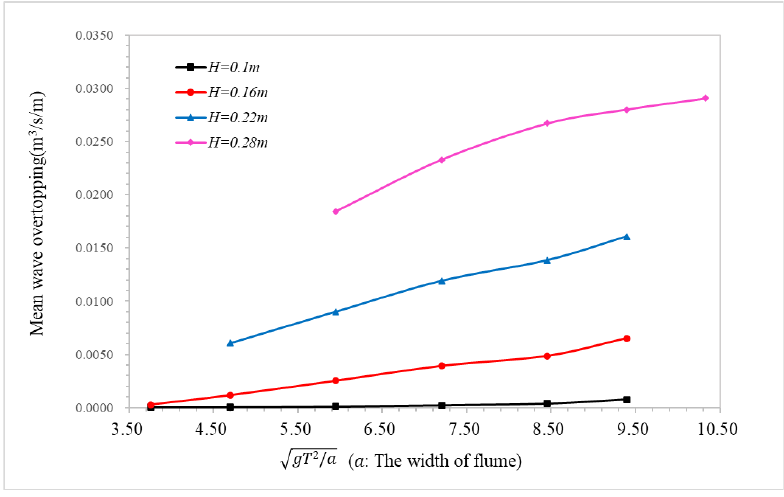
(cid:112) 2 / g T a gT 2 / a .